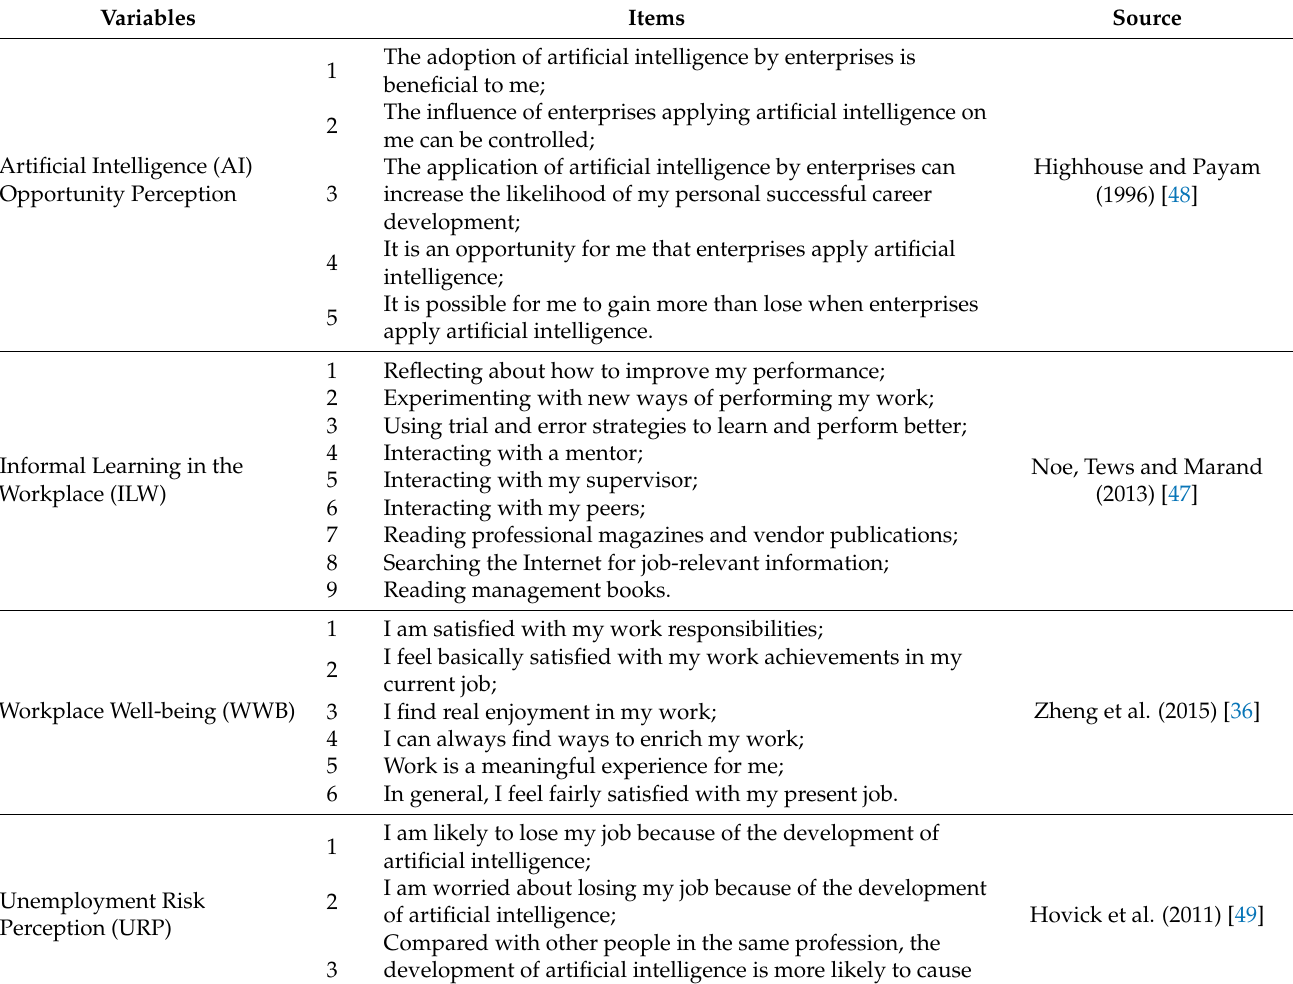
Table A1. Measurement items of key